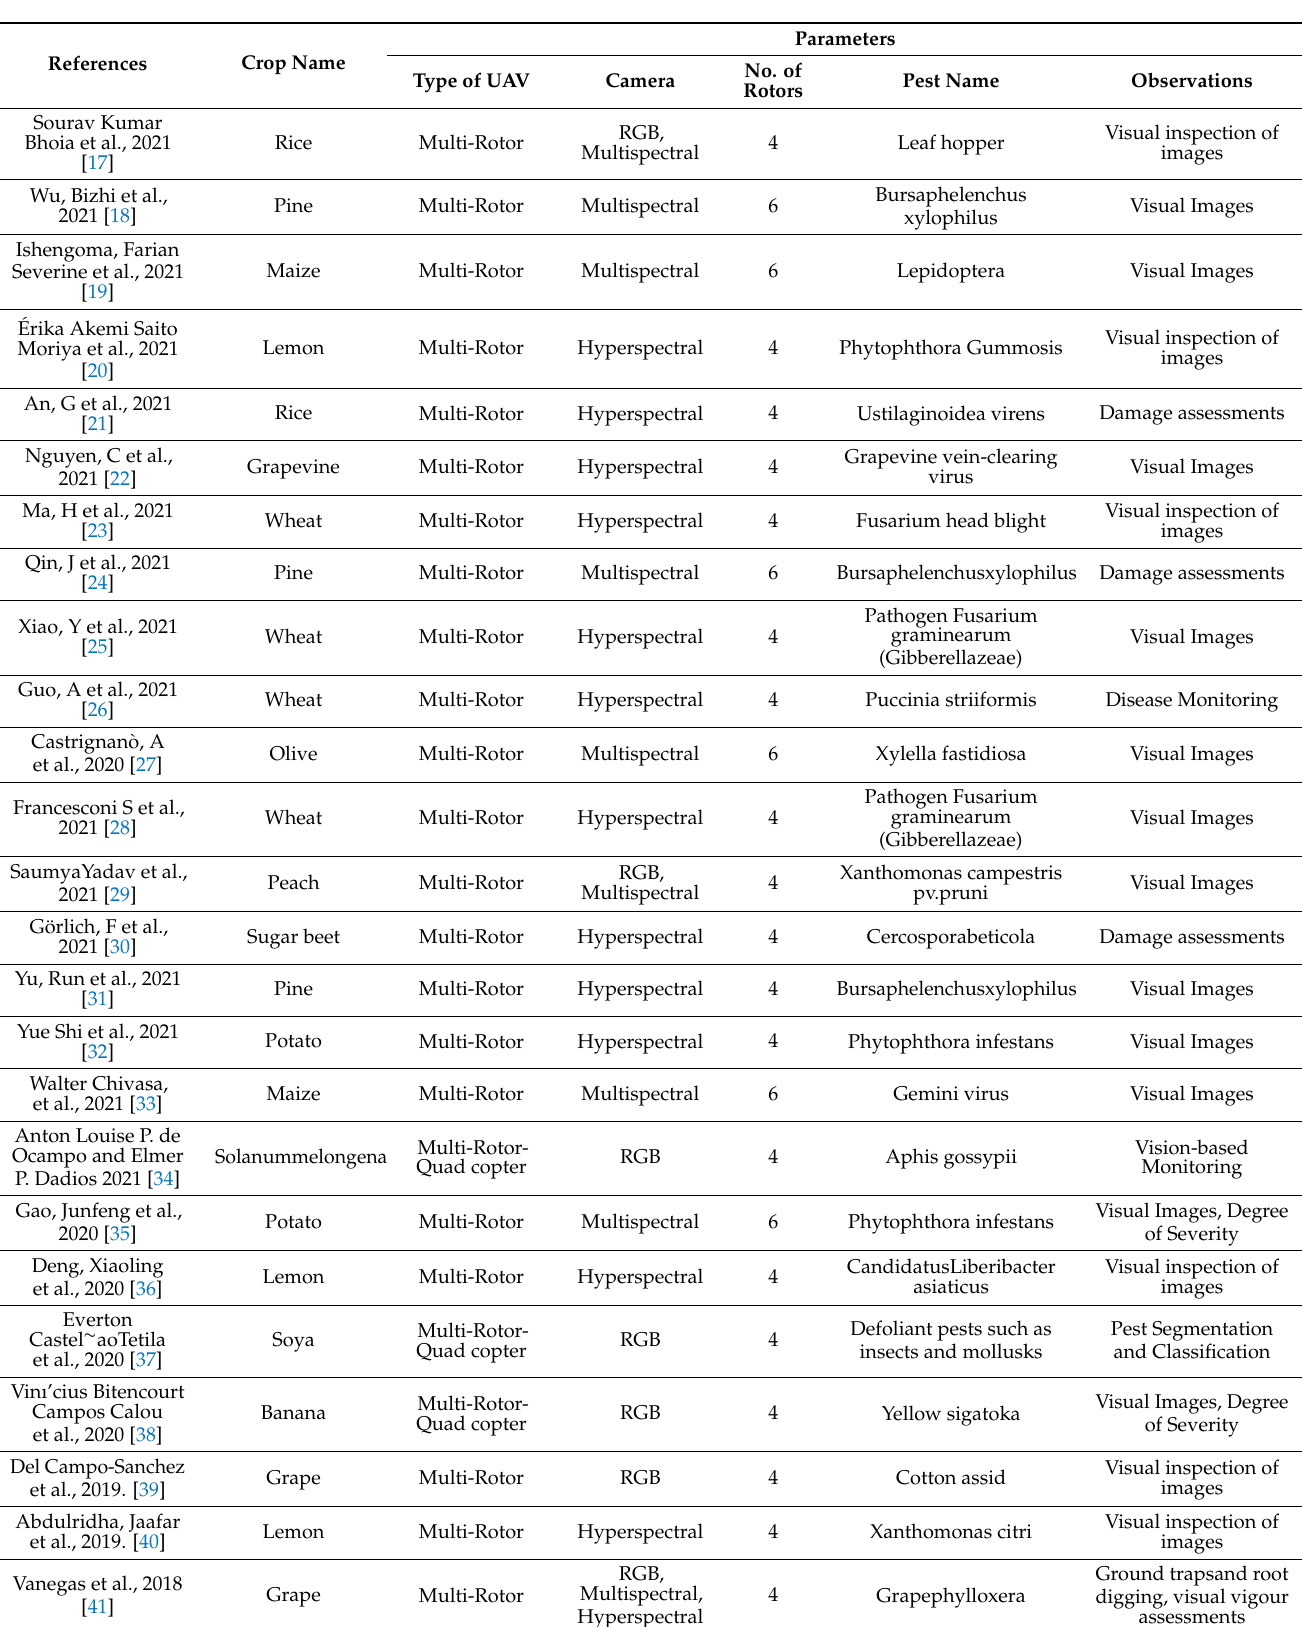
Table 3. UAV based remote